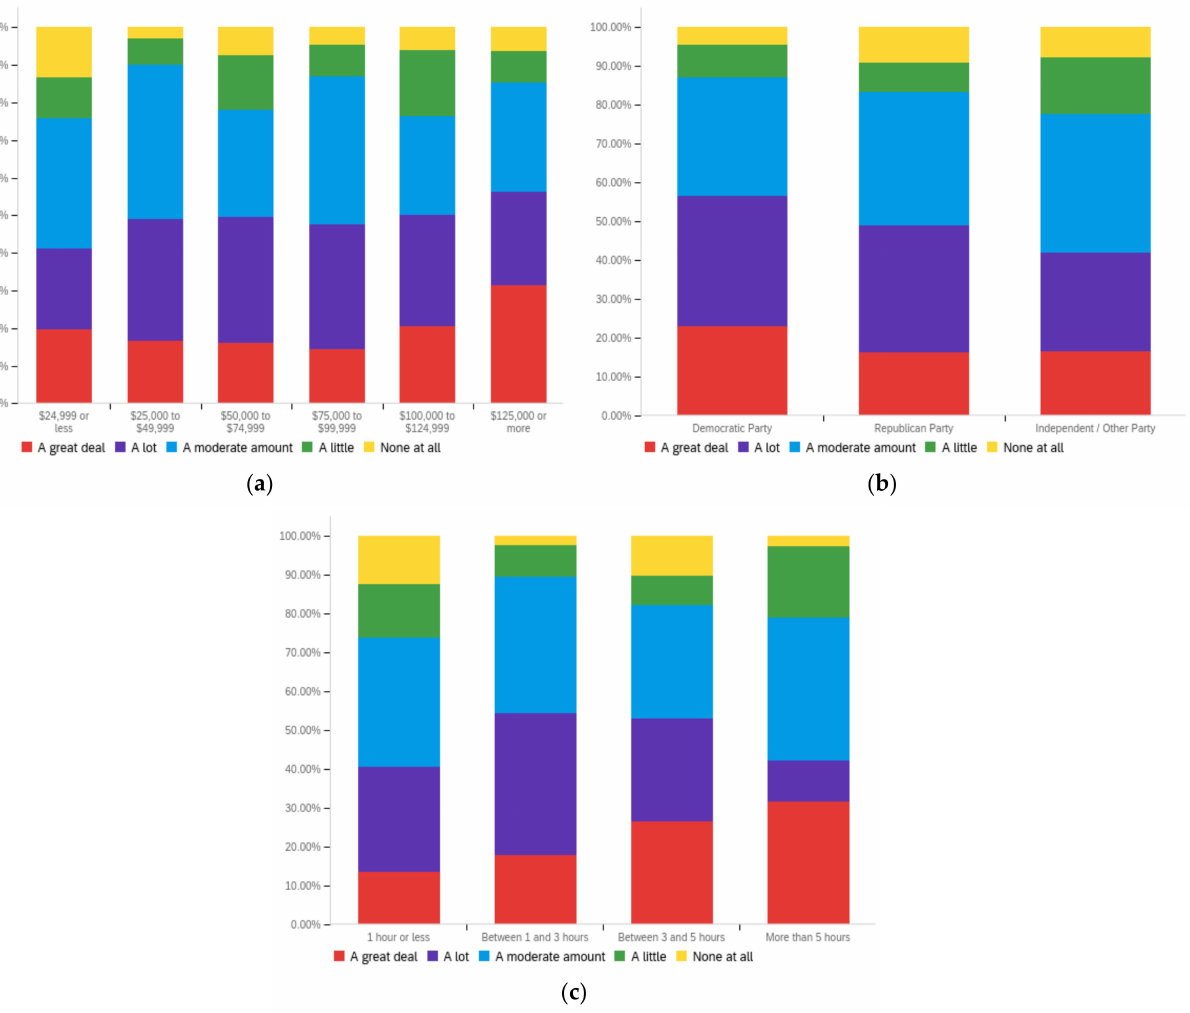
Figure A10. Article author—personal perception impact by: ( a ) income level (top left), ( b ) political affiliation (top right) and ( c ) online usage (bottom).